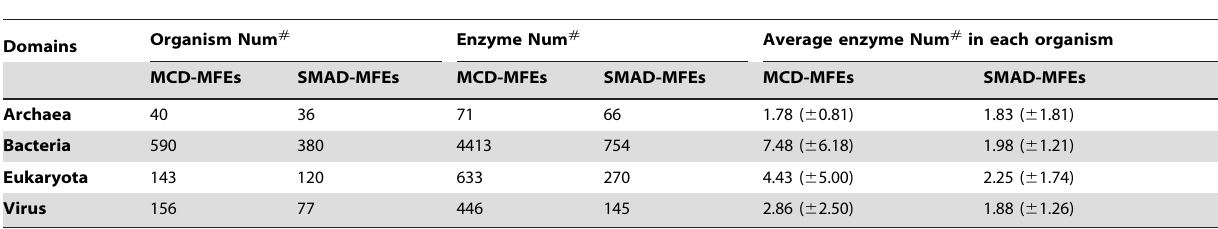
Table 3. The distribution of MFEs in four life domains of Archaea, Bacteria, Virus and Eukaryota.